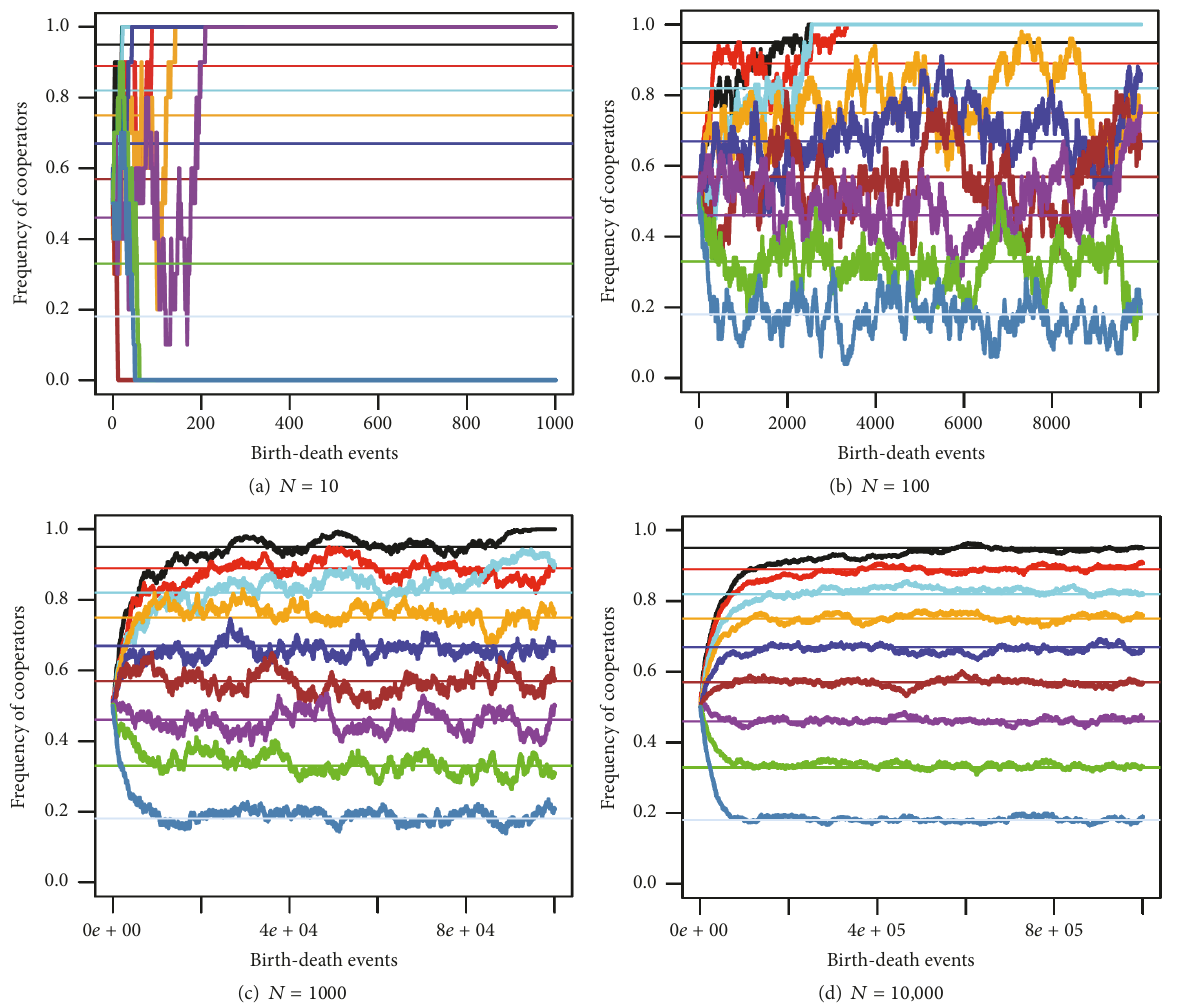
Figure 5: Simulation results of within-group Moran process. Each panel shows the evolution of cooperation in each of nine different groups over the course of 100 generations within each group. Within a panel, groups are all the same size but vary in their r -values. The range of r -values that were simulated was 𝑟 ∈ {0.1, 0.2, 0.3, 0.4, 0.5, 0.6, 0.7, 0.8, 0.9} , where b was set to 10 and c ranged from 1 to 9 in increments of 1. The jagged lines represent the frequency of cooperators in a group. As r -values get larger, the equilibrium frequency of cooperators gets smaller; thus, 𝑟 = 0.1 is black, while 𝑟 = 0.9 is teal. Each horizontal line of a corresponding color represents the equilibrium frequency of cooperators for that r -value given by